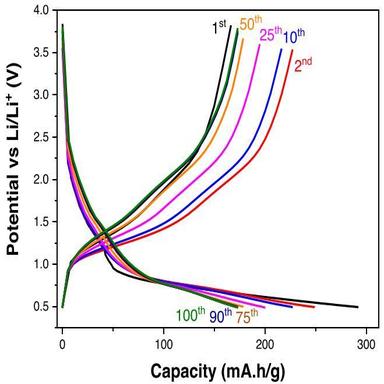
Cell voltage as a function of specific capacity obtained by charging and discharging at 30 mA/g.